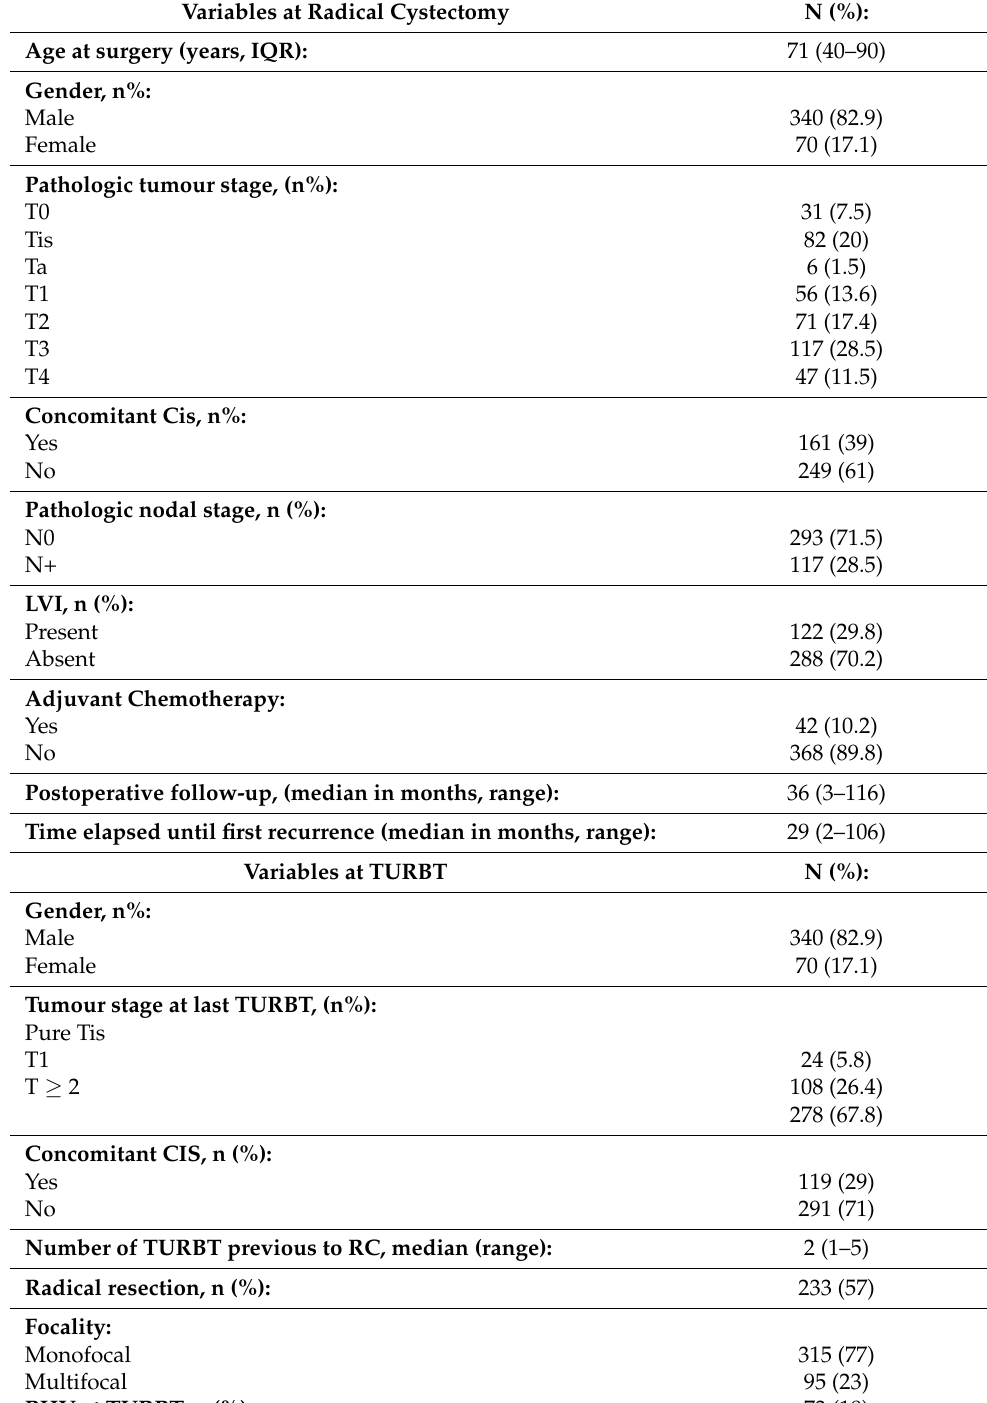
Table 1. Clinical–pathological characteristics of patients after RC and TURBT according to the TNM classification (VIII